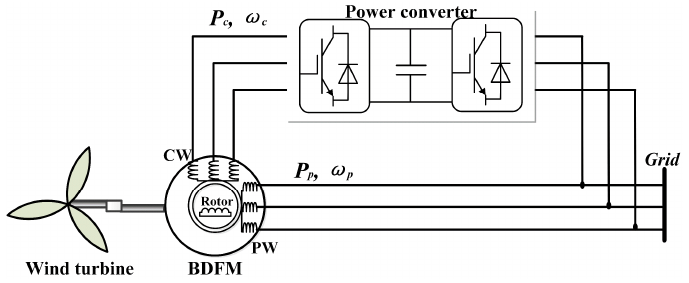
Figure 1. The schematic diagram of the brushless doubly fed induction machine system.